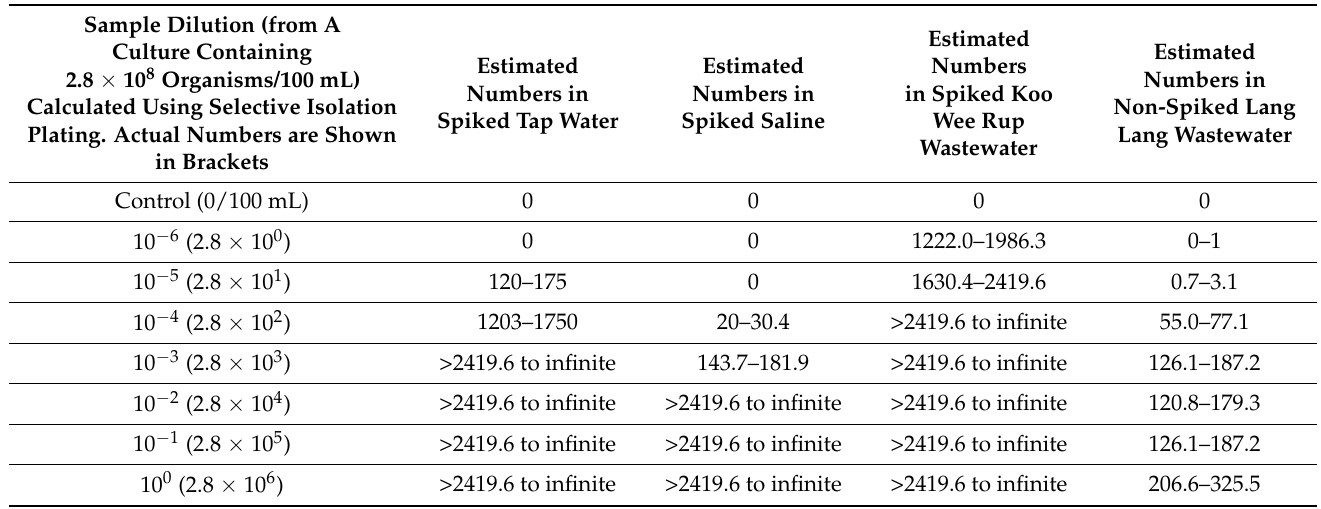
Table 2. Estimated numbers of E. faecalis present in spiked tap water, saline, Koo Wee Rup wastewater, and Lang Lang wastewater, assessed using the Enterolert-E test (in organisms/100